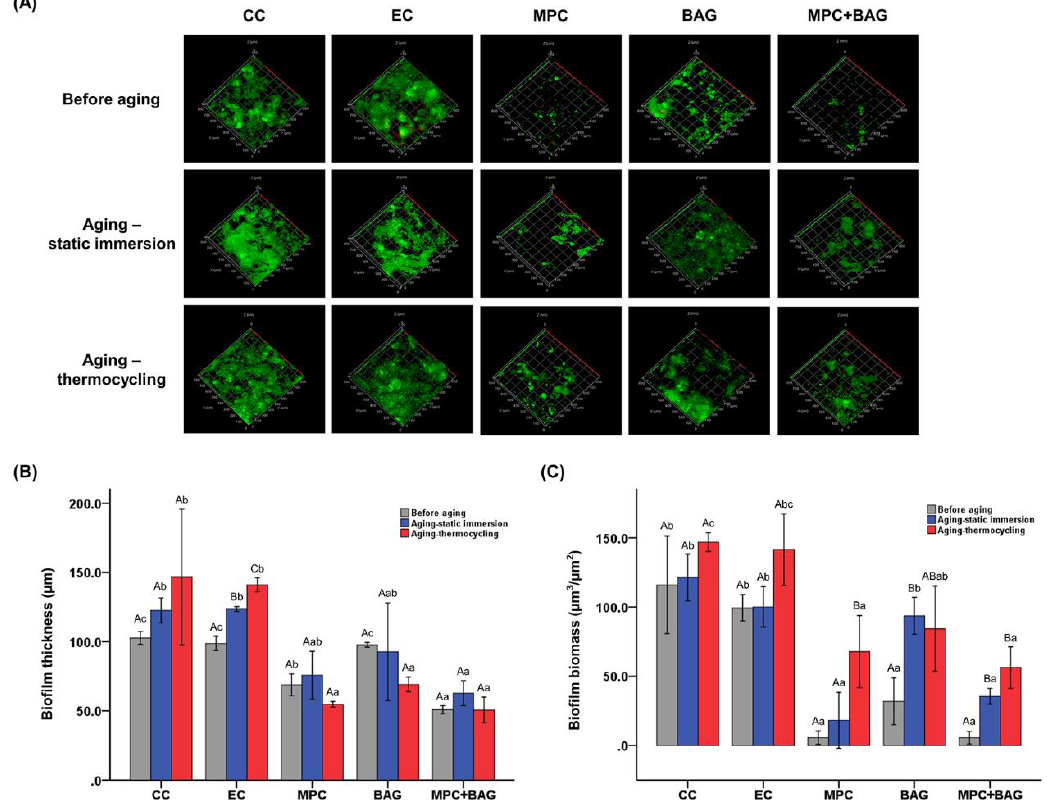
Figure 5. Representative live / dead staining images of the biofilm attached on the surfaces in the groups under three di ff erent conditions: before aging, with static immersion aging, and with thermocycling aging ( A ). Quantitative analysis of the thickness ( B ) and biomass ( C ) of the biofilms. The groups are: Commercial control (CC), experimental control of 50 wt% resin matrix + 50 wt% glass filler (EC), 48.5 wt% resin matrix + 48.5 wt% glass filler + 3 wt% MPC (MPC), 50 wt% resin matrix + 37.5 wt% glass filler + 12.5 wt% BAG (BAG), and 48.5 wt% resin matrix + 36.38 wt% glass filler + 12.12 wt% BAG + 3 wt% MPC (MPC + BAG). The uppercase and lowercase letters indicate the statistically significant di ff erences within the groups and between groups, respectively.